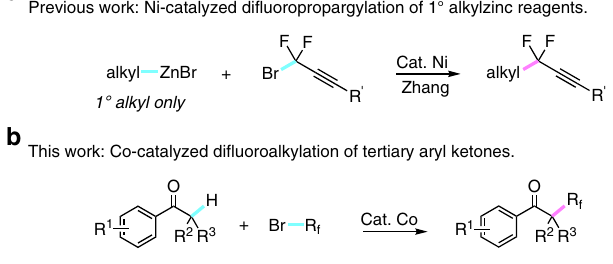
Fig. 1 Transition-metal-catalyzed cross-coupling for facile synthesis